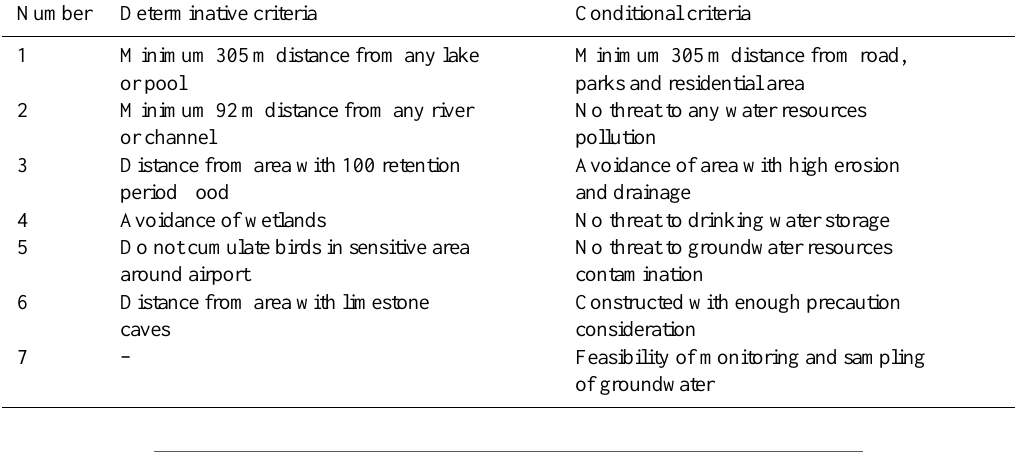
Table 1. Six determinative and seven conditional factors of MPCA method (Badve, 2001).